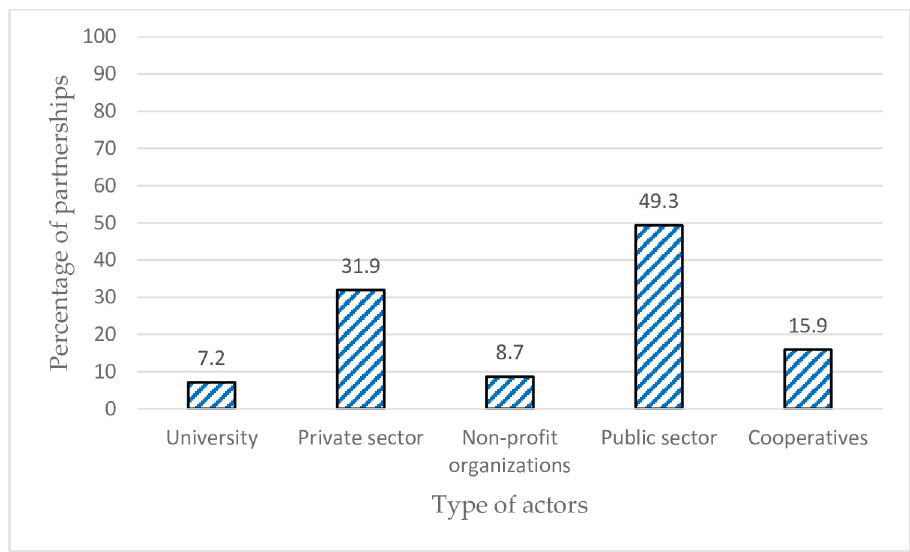
Fig 5. Type of actors participated in the partnerships (Some partnerships included more than one